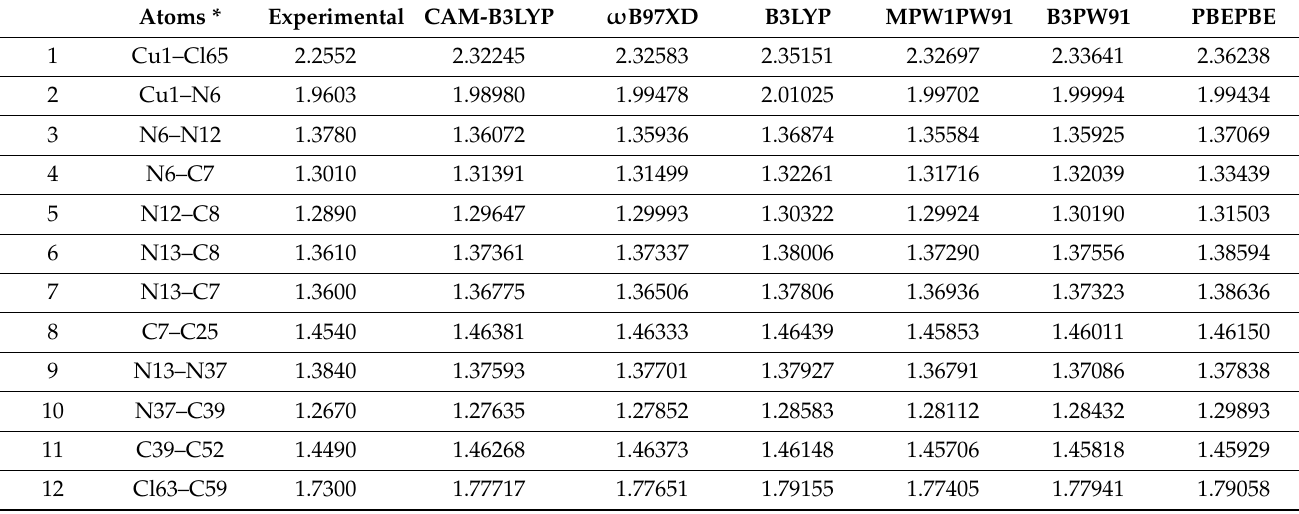
Table 1. Comparison of selected experimental and calculated bond lengths (Å) for the Cu (II) - complex ( 6 ) using 6-31G(d)/LanL2DZ mixed basis